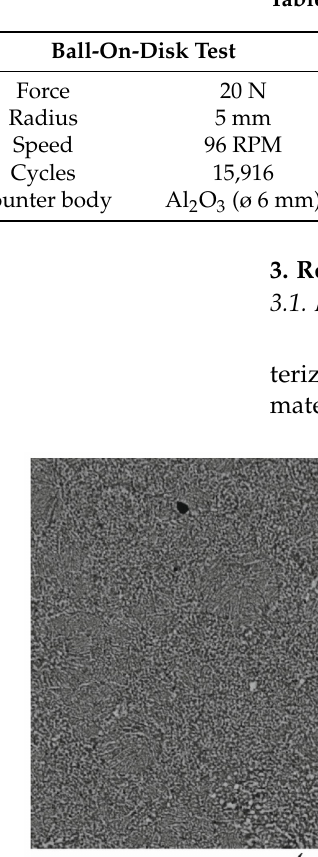
Table 2. Wear test parameters.